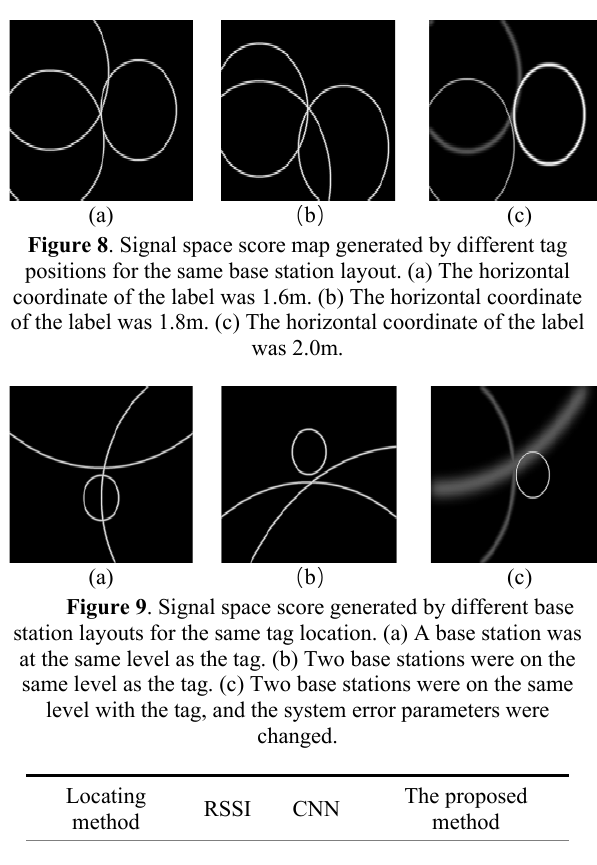
Figure 7 . (a) Signal space score map generated by setting parameters such as beacon distance. (b) Calculated canvas offset given the true coordinates of the label, corrected signal space score.